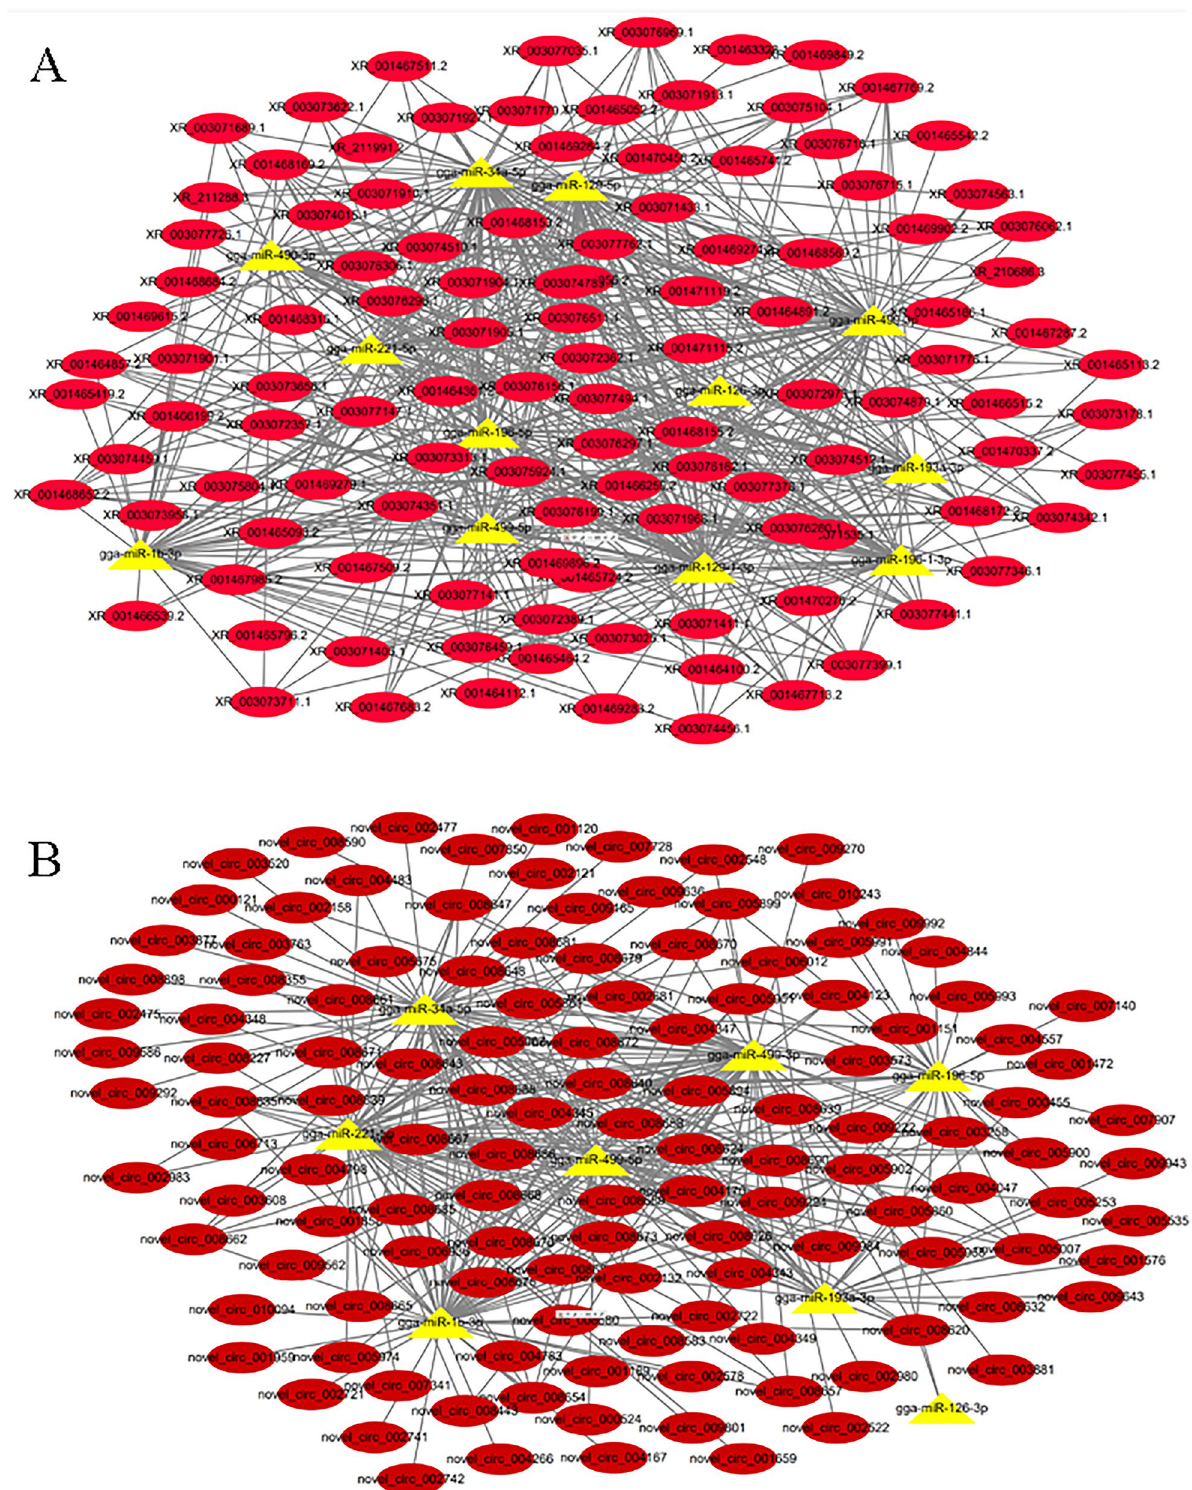
Figure 7. LncRNA-miRNA/circRNA-miRNA interaction network. ( A ) LncRNA-miRNA interaction network. LncRNA is shown in circular and red, miRNA is shown in the triangle, and yellow. ( B ) MircRNA-miRNA interaction network. CircRNA is shown in circular and red, miRNA is shown in the triangle, and